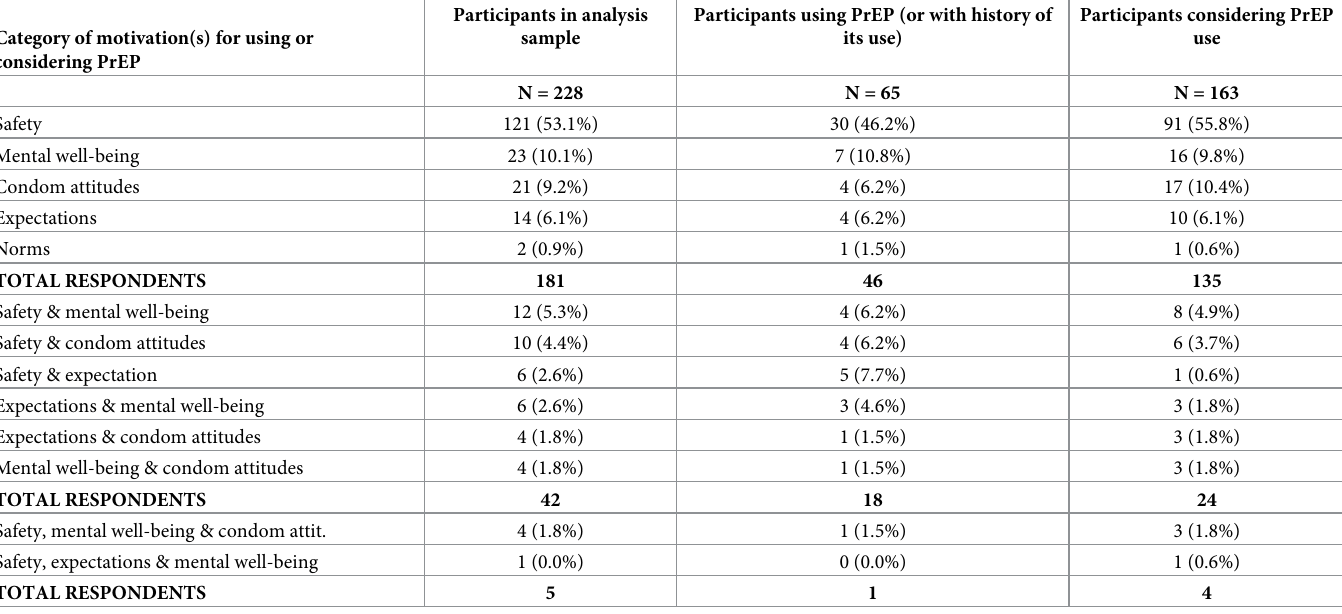
Table 3. Participants reporting one or more motivations exclusively in a category or combination of categories in the analysis sample, by subgroup (using or consid- ering PrEP). Category of motivation(s) for using or considering